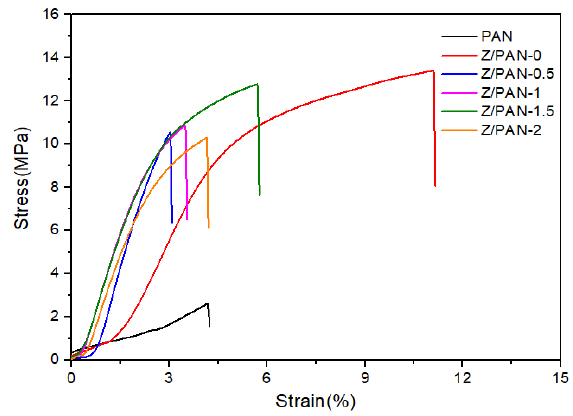
Figure 3. The stress–strain curves of different separators.